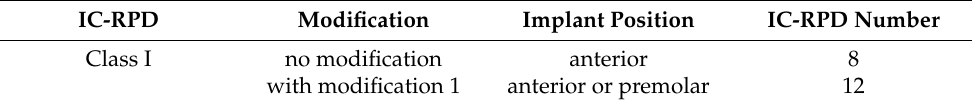
Table 1. Kennedy-Applegate classification in the implant-crown-retained removable partial dentures (IC-RPD) group.